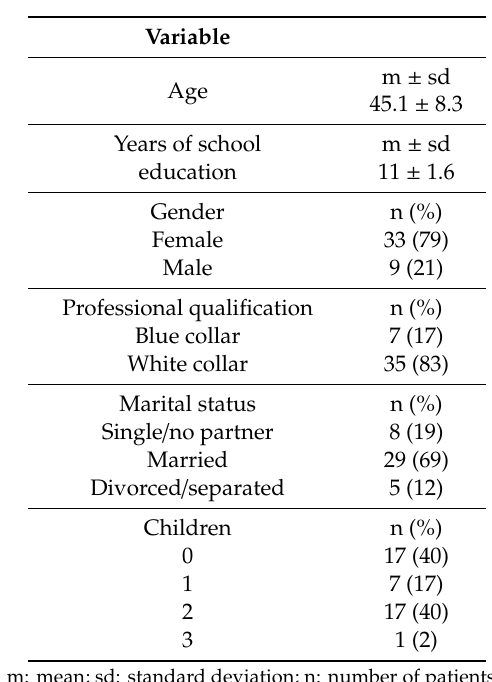
Table 2. Sociodemographic